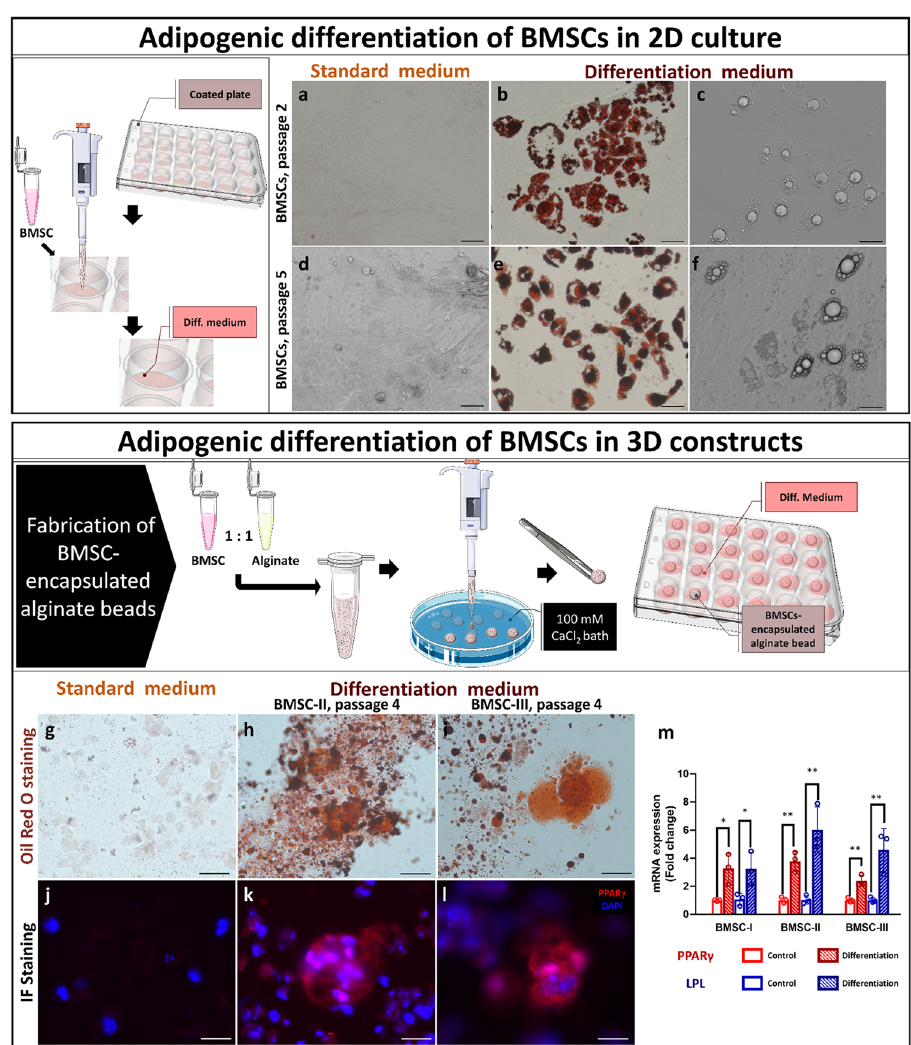
Fig. 1 Adipogenic differentiation of isolated BMSCs within 3D construct. Top panel: BMSCs were seeded in 2D culture plates, and then differentiated into adipocytes by application of differentiation medium for 12 days. Image credits: this fi gure was created using elements from Servier Medical Art (https://smart. servier.com). Representative bright- fi eld and ORO staining images of b , c , e , f post-differentiated BMSCs and a , d non-induced BMSCs at passages 2 and 5; scale bar 50 µ m. Bottom panel: BMSCs were loaded into 0.5% alginate hydrogel beads and cultured in differentiation medium (illustration of the process in the bottom panel). Image credits: this fi gure was created using elements from Servier Medical Art (https://smart.servier.com). ORO-stained sections of BMSC- loaded beads cultured in g standard or h , i differentiation medium for 19 days. PPAR γ -stained sections of BMSC-loaded beads cultured in j standard or k , l differentiation medium for 19 days (red, PPAR γ ; blue, DAPI); scale bar 20 µ m. m Relative fold-change of LPL and PPAR γ mRNA expression, measured using real-time qPCR, in differentiated BMSCs of each isolation (BMSC-I, BMSC-II, and BMSC-III). Fold-change in expression was calculated using the ΔΔ Ct method after normalization with endogenous reference 18s or GAPDH. Differences between gene expression levels of BMSCs loaded into beads cultured in differentiation versus standard medium (control) were evaluated using Student ’ s t -test and reported as the mean±SE of triplicates, * p <0.05, ** p